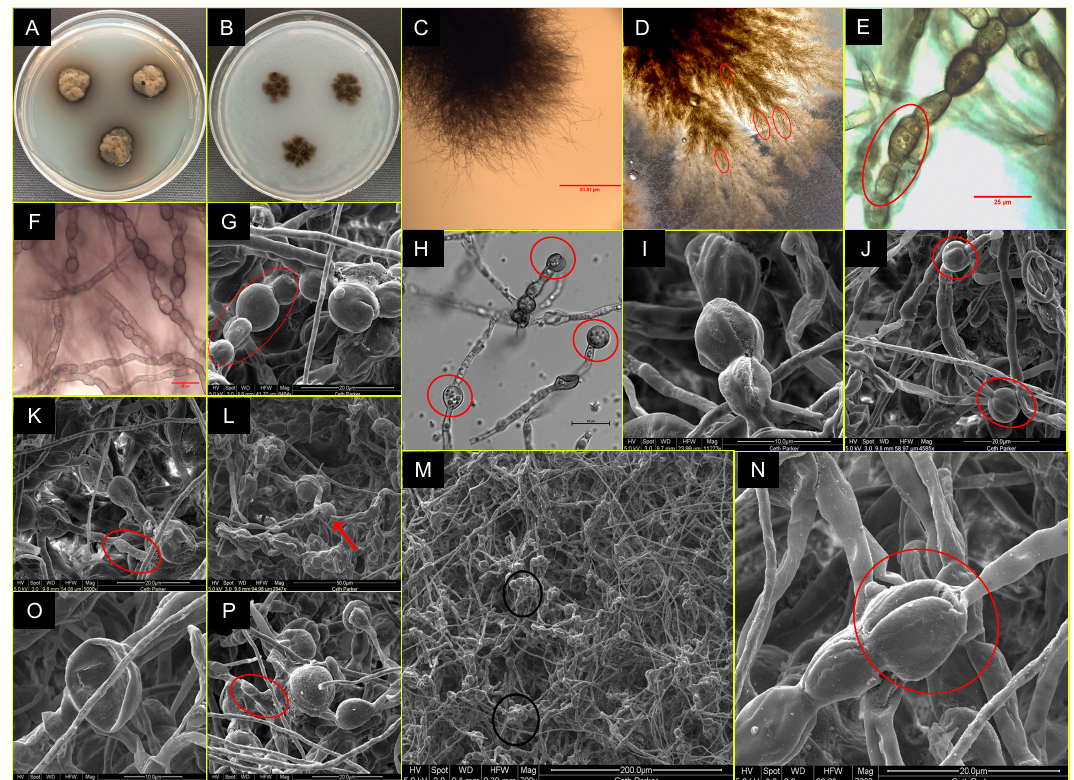
Figure 7. Colony and cell morphology of F. radiotolerans . Colony surface of F. radiotolerans after 14 days of incubation at room temperature (25 ◦ C) on ( A ) PDA medium and ( B ) OMA medium. ( C ): Bush form vegetative morphology of young vegetative hyphae. ( D ): Highly branched mature hyphae showing dark brown nodes of conidiomata. ( E – F ): Vegetative hyphae are smooth-walled, septate with chlamydoconidium-like cells. ( G ): Chlamydoconidium-like cells. ( H ): DIC microscopy showing mature bulbous swollen chlamydoconidium-like cells containing endoconidium-like round